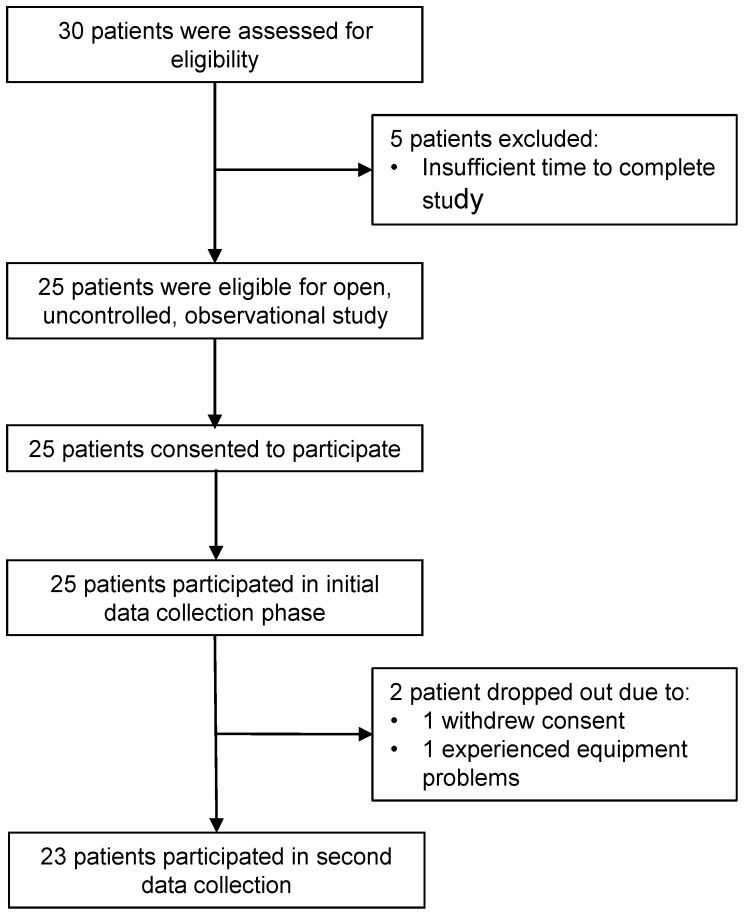
CONSORT flow diagram showing enrollment and retention of volunteers in the study of energy expenditure in type 1 diabetes.